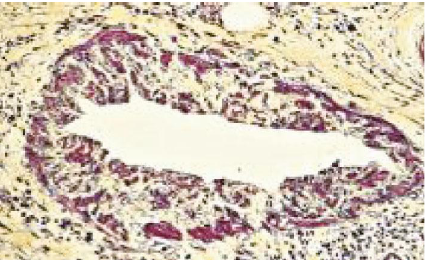
Figure 34: Vasospastic venous angiopathy. The small intestinal vein without signi fi cant adventitial muscle shows reparative fi brosis replacing lysed medial muscle providing another morphologic appearance to venous FMD. Movat stain × 100 (adapted with permission from the International Journal of Surgical Pathology 15(2) copyright 2007, Sage Publications).